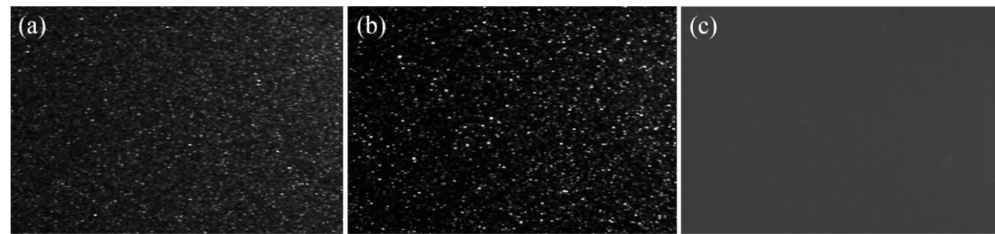
Figure 4. GOHYLED sparkle images of ( a ) a pearlescent, ( b ) a metallic and ( c ) a solid sample for the − 15 ◦ x:0 ◦ geometry when illuminated with the white LED